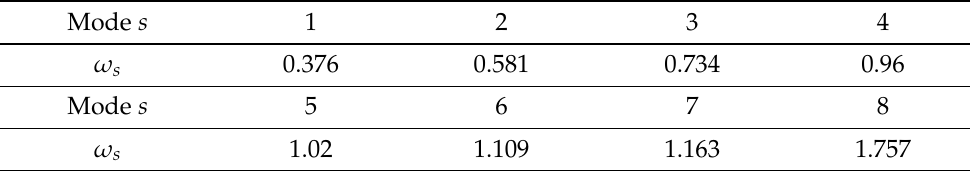
Table 1. Lowest eight nondimensional circular